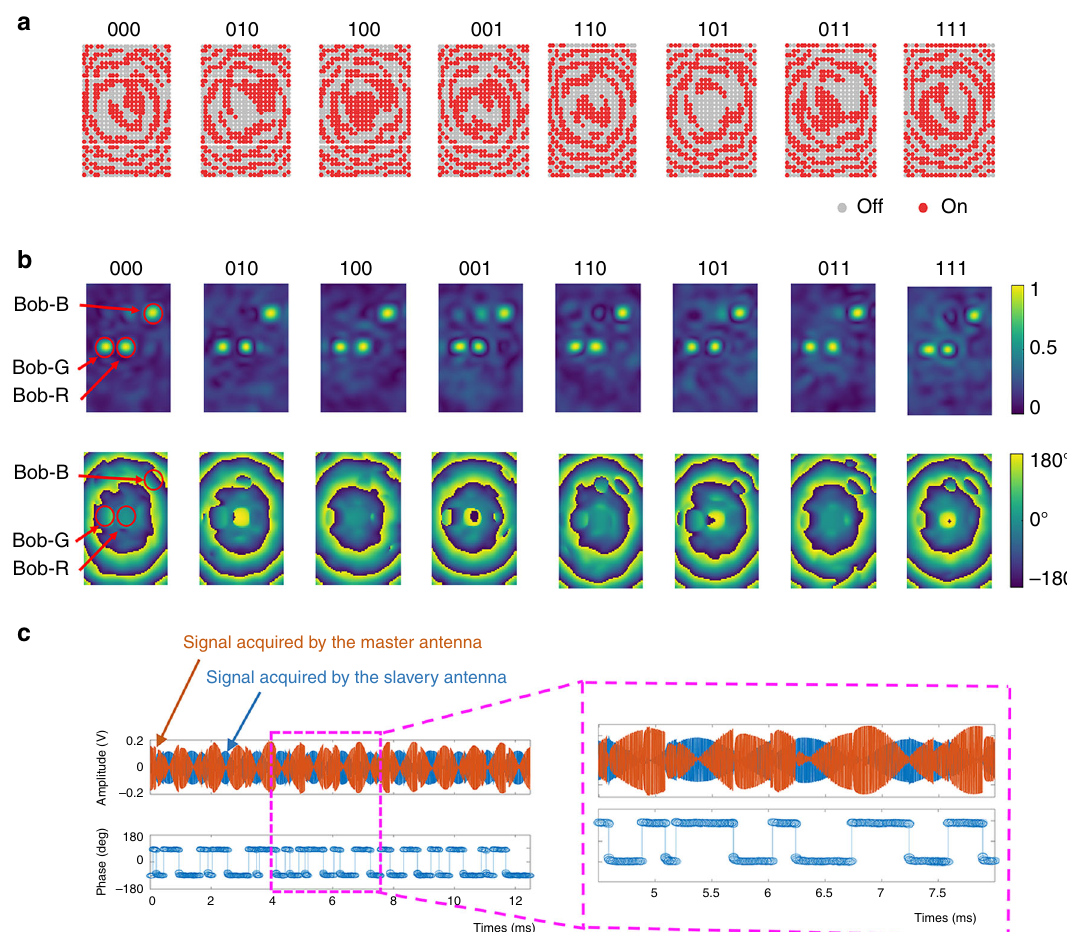
Fig. 4 Results of the three-channel binary PSK MBWC. a Optimized coding patterns for the three-channel MBWC-BASK. b Amplitude (top) and phase (bottom) distributions of H s → meta → mr , corresponding to the eight coding patterns plotted in ( a ) at 2.412 GHz. Amplitude and phase of information-carrying stray Wi-Fi signals can be well controlled for the purpose of passive phase modulation. c (top) the stray Wi-Fi signals with about 12 ms length, which are acquired by the master (red line) and slavery (blue line) antennas, (bottom) the corresponding phase retrieved by the proposed MBWC demodulation method. Further, the signal parts within the range of 4 – 8 ms marked in purple are enlarged at the